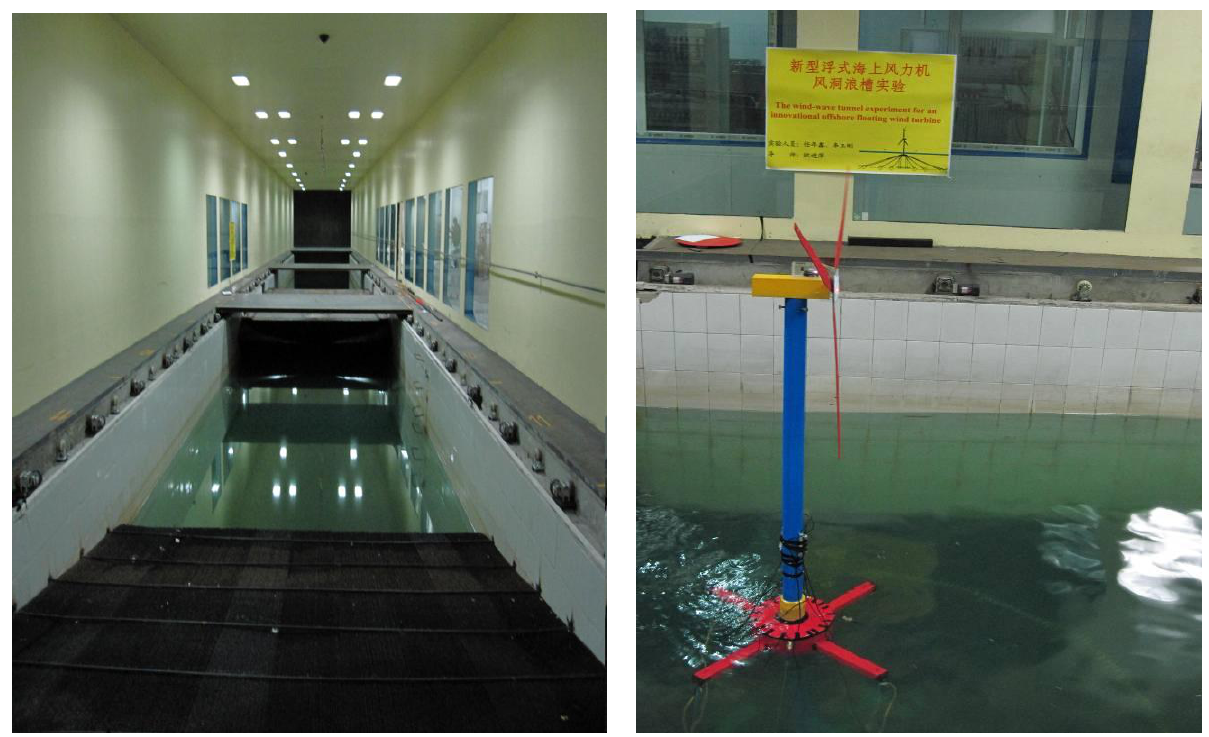
Figure 1. Experimental model. ( a ) The large test section in the wind-wave tunnel ( left ); ( b ) The scaled test model system ( right